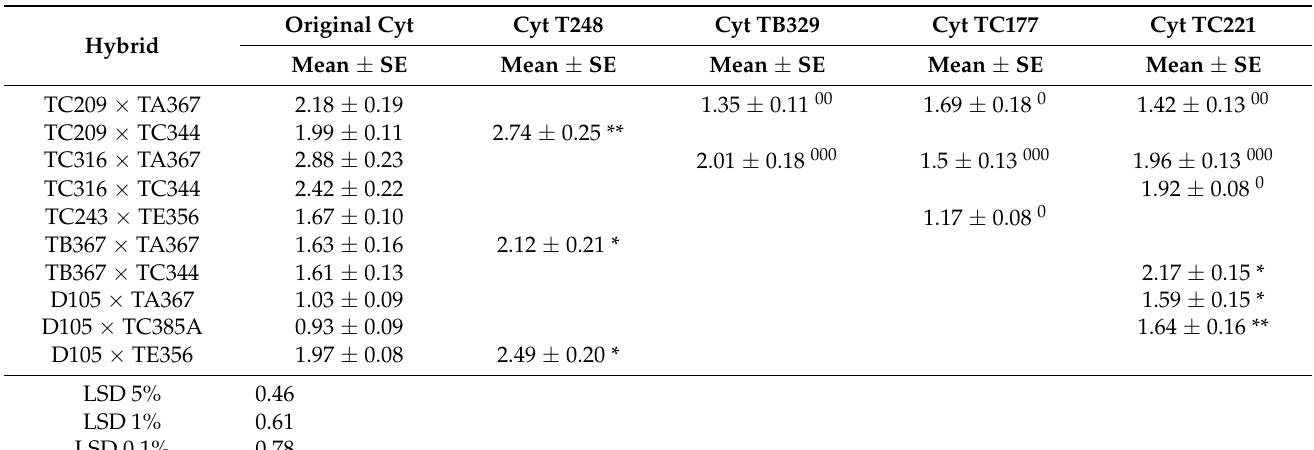
Table 8. The influence of cytoplasm × nucleus × tester interaction on some hybrids’ zeaxanthin content ( µ g/g)—ANOVA